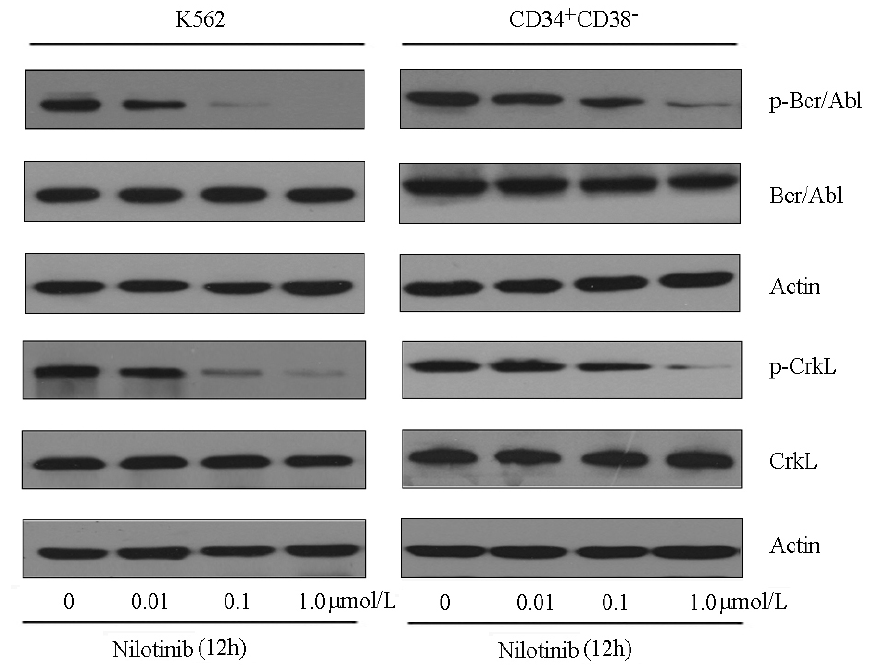
Figure 6. Effect of nilotinib on Bcr-Abl kinase activity in ABCB1- and ABCG2- overexpressing CD34 + CD38 − cells. K562 parental cells and CD34 + CD38 − subpopulation isolated from K562 cells were treated with nilotinib at 0.01, 0.1 and 1.0 μ mol/L for 12 h. Equal amount of protein was loaded for western blot analysis as described in the Experimental section. The experiments were repeated at least three times